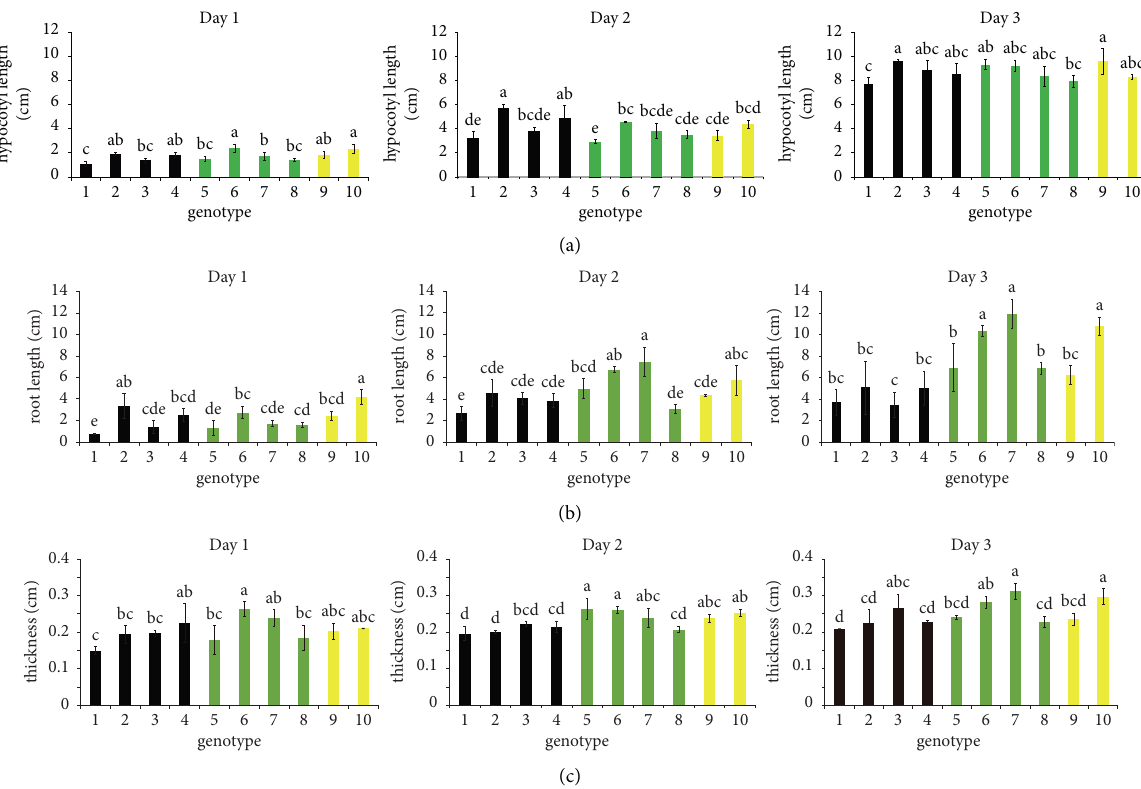
Figure 2: Phenotypic traits of 10 mungbean sprouts at 1, 2, and 3 DAGs. (a) Te length of the hypocotyl; (b) the length of the root; (c) the thickness of the hypocotyl. Te colors of each bar (black, green, and yellow) indicate the seed coat color. Te error bar indicates the standard deviation. Lowercase letters above the bar indicate statistical signifcance ( p < 0 .